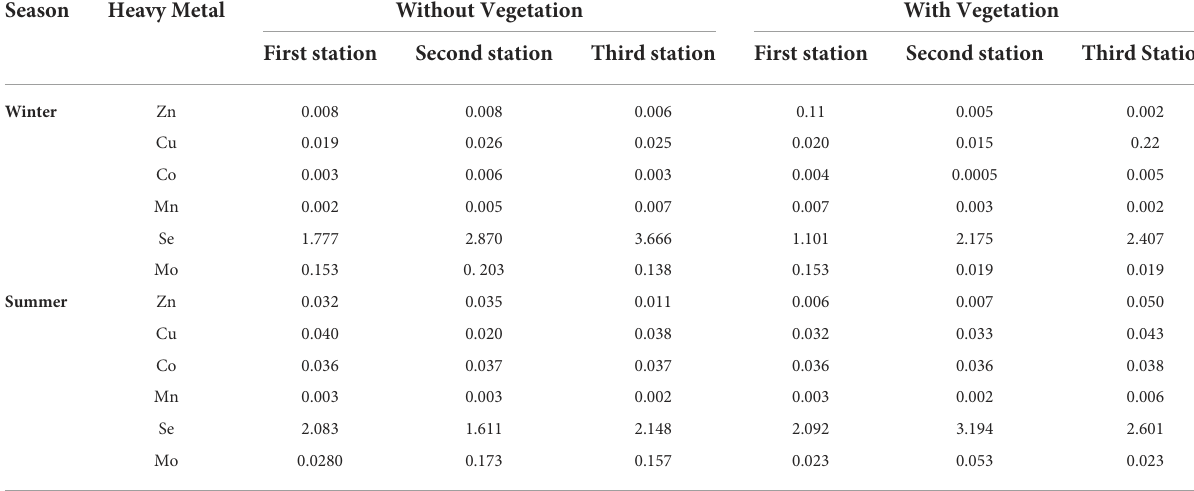
TABLE 4 The heavy metal contamination factor (CF) in the coastal Shadegan soils in winter of 2019.